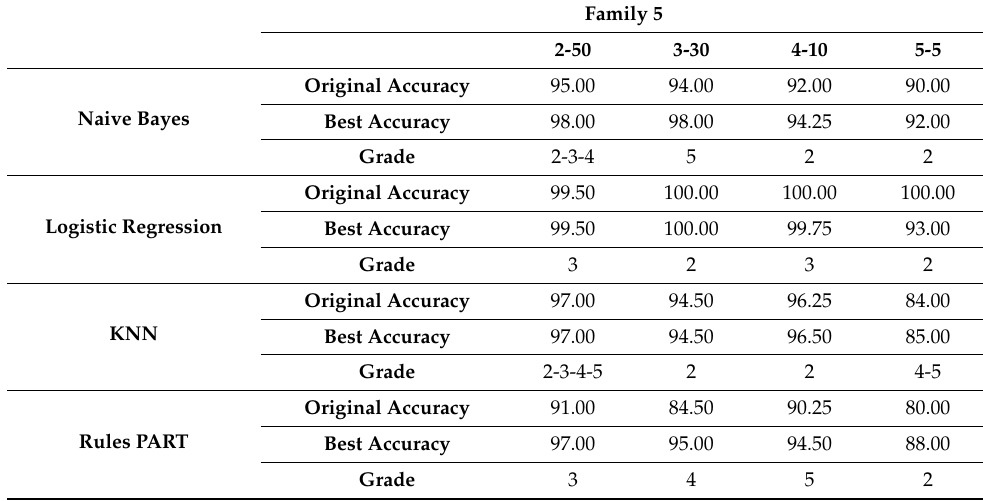
Table A5. Table corresponding to results of artificial data from Family